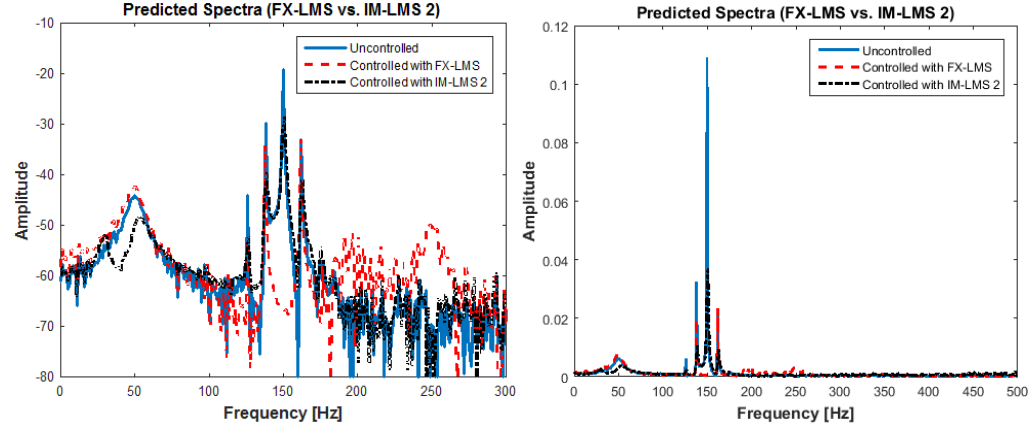
Figure 11. Predicted spectra for a frequency-modulated (FM) signal with least mean squares and internal model least mean squares 2 methods.